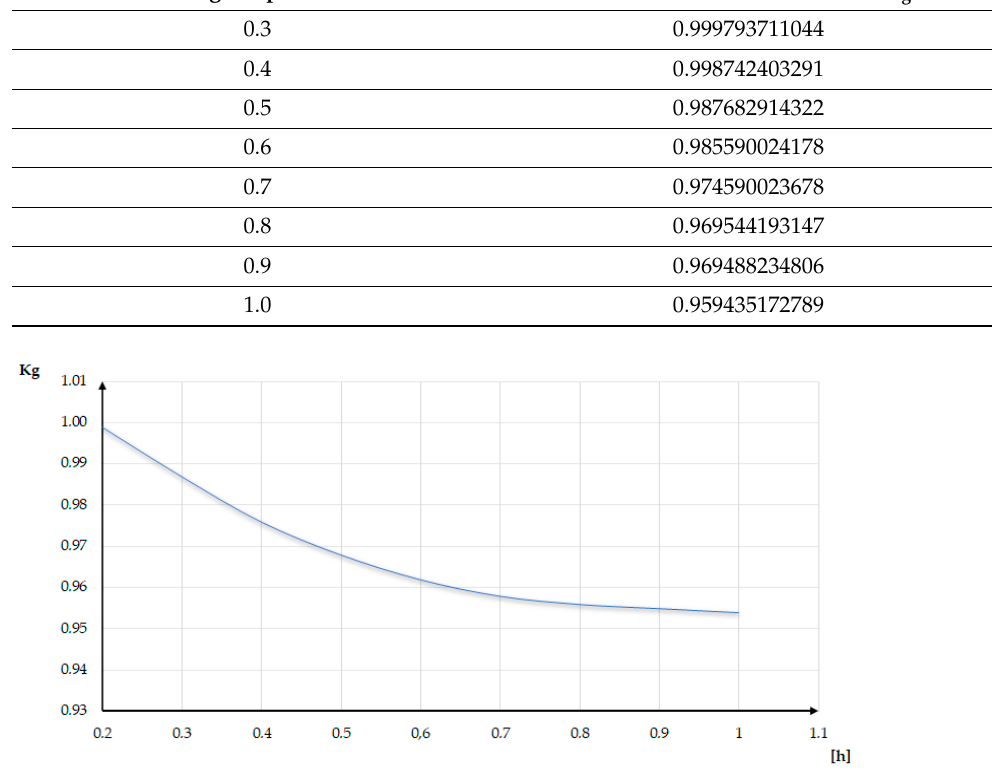
Figure 8. Graph of the reliability of wind farm devices in the operation process as a function of repair time.